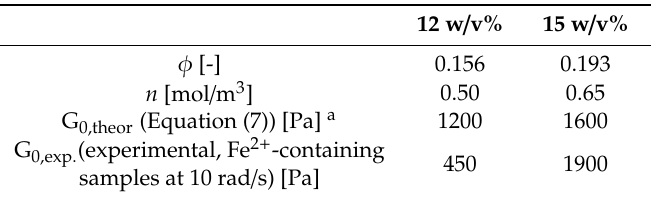
Table 1. Plateau moduli calculated at T = 20 ◦